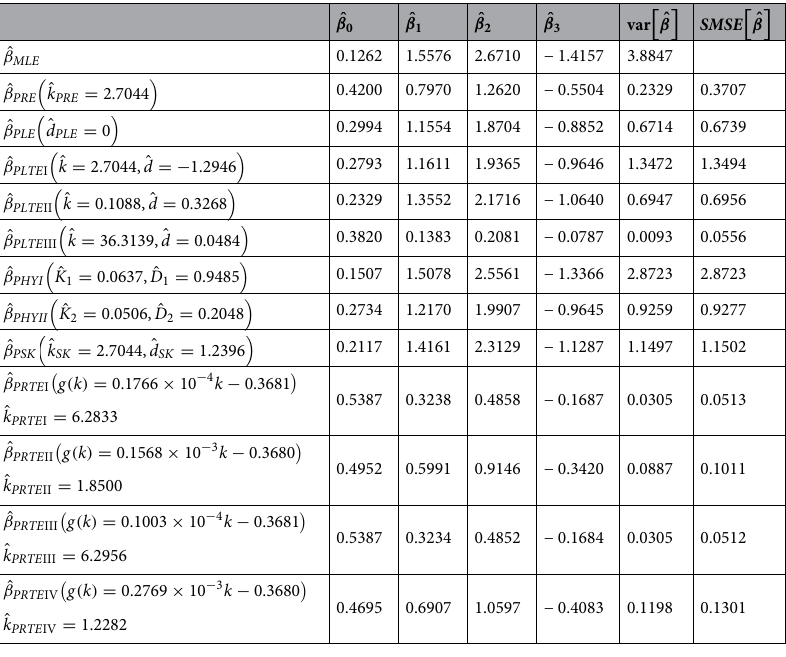
Table 5. The estimated parameter values and the SMSE values of the estimators.